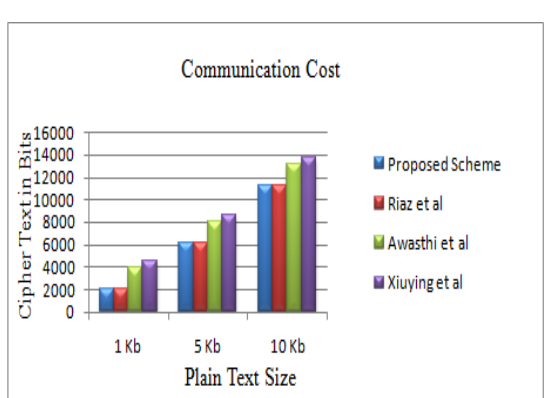
Fig. 5: Communication Cost Comparison using different size of messages forwarding secrecy, and non-